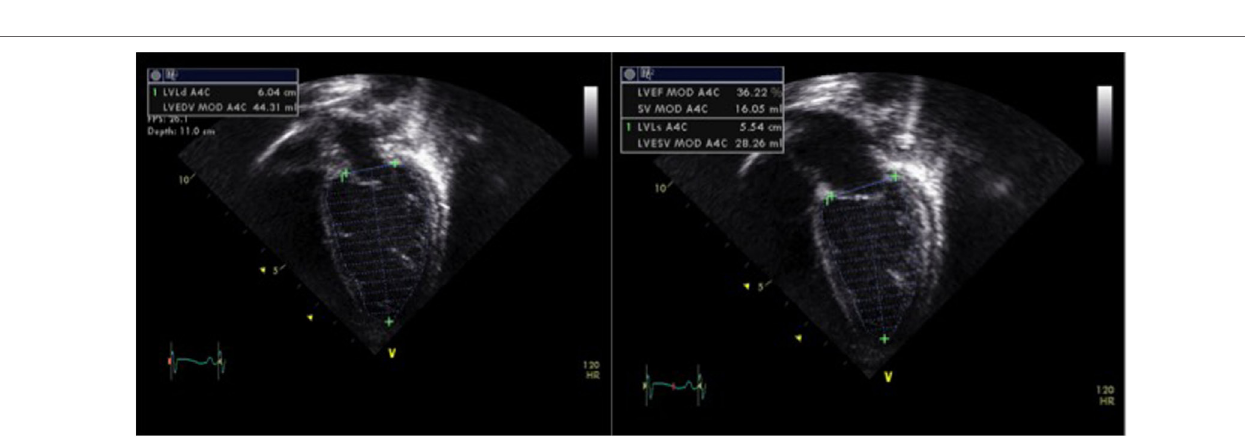
FigURe 3 | Assessment of left ventricular systolic function by planimetry using the modified Simpson’s method and allowing estimation of the ejection fraction (EF) by tracing the endocardial left ventricular border in end-diastole (LVEDV) and in end-systole (LVESV), obtained from a patient with moderate left ventricular systolic dysfunction (EF = 30%). Abbreviations: LVEF, left ventricular ejection fraction; LVEDV, left ventricle end-diastolic volume; LVESV, left ventricle end-systolic volume; SV, stroke